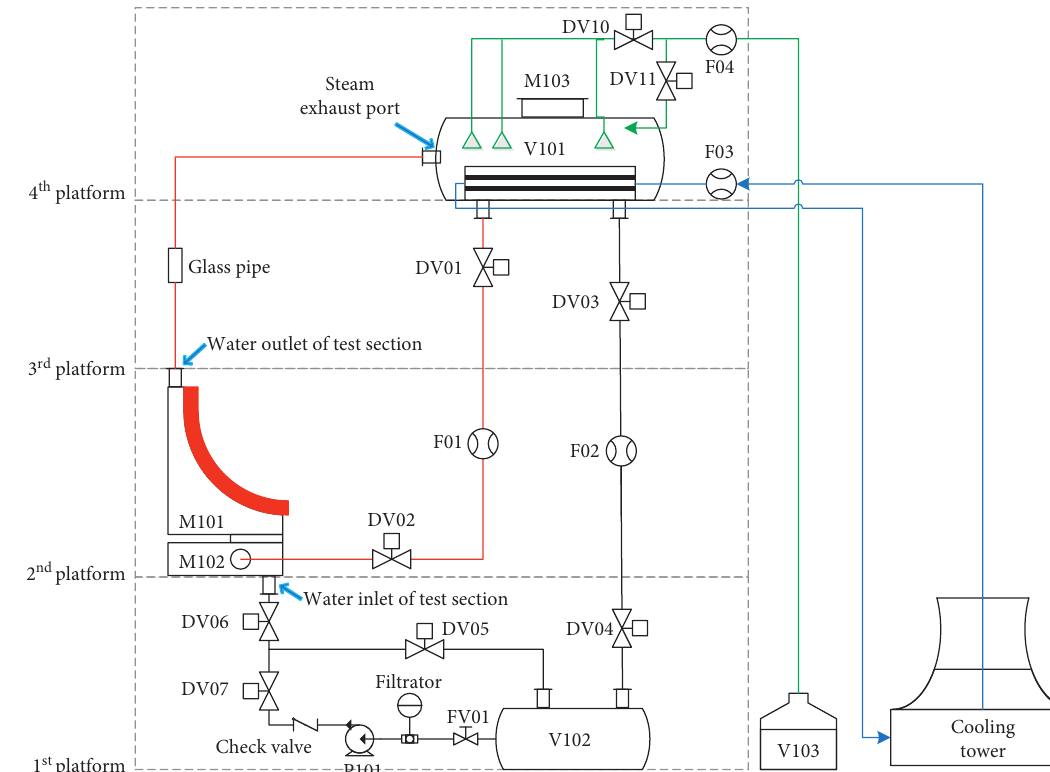
Figure 3: The flowchart of REVECT test facility.